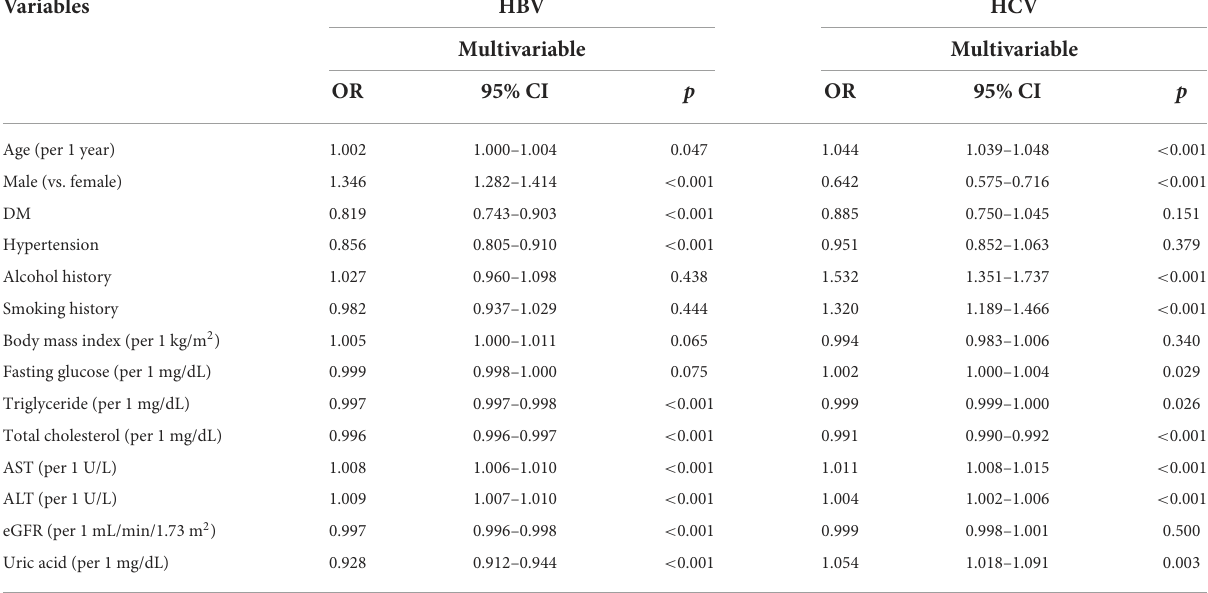
TABLE 2 Determinants for HBV and HCV infections using multivariable logistic regression analysis.